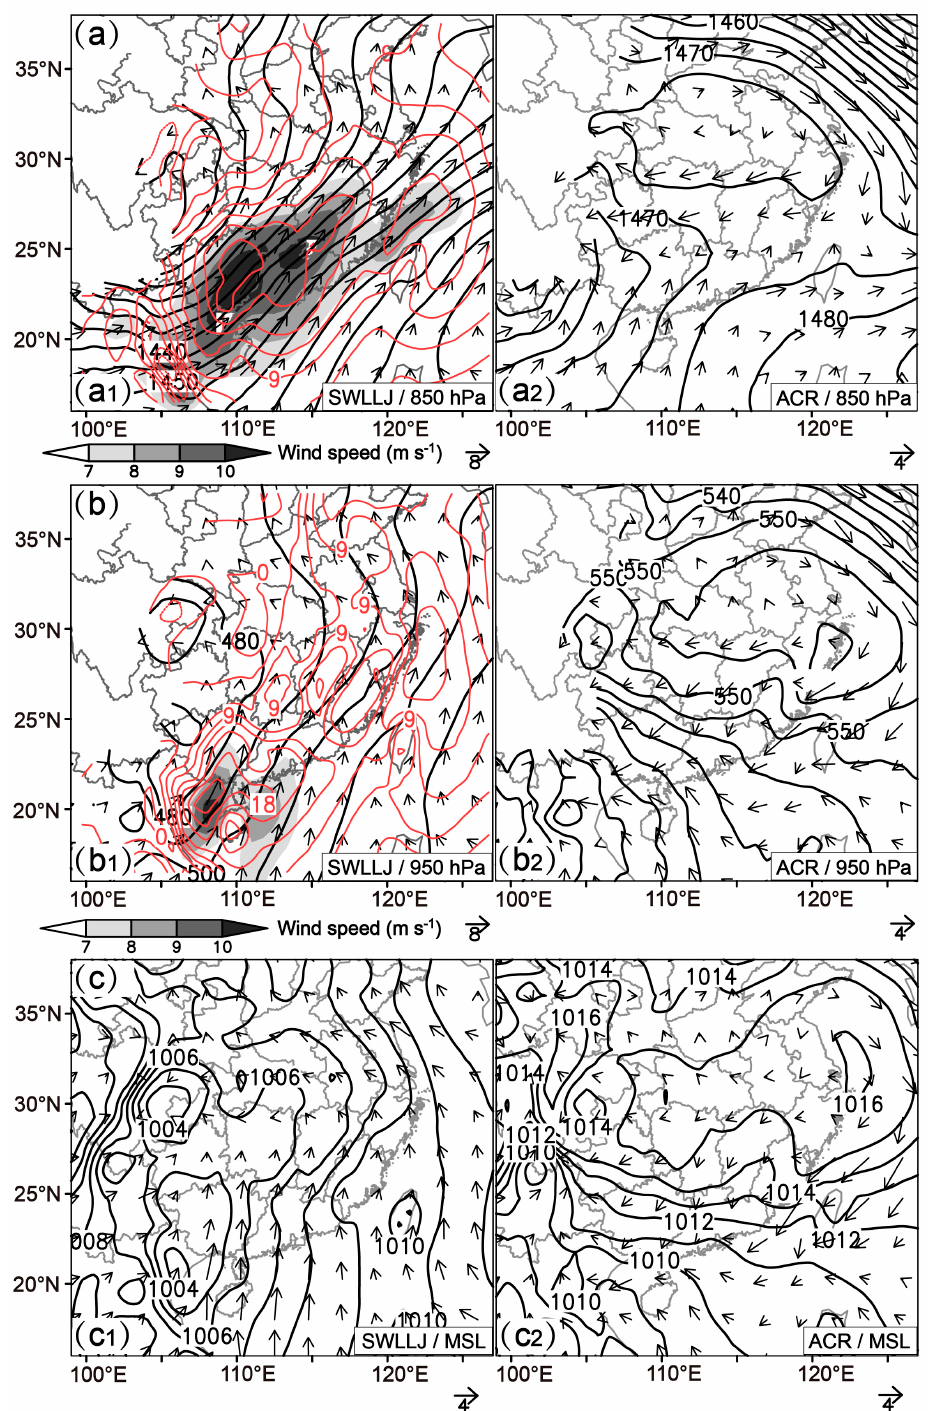
Figure 4. Two types ( a 1 , b 1 and c 1 representing synoptic situation SWLLJ; a 2 , b 2 and c 2 representing synoptic situation ACR) of composite ( a , a 1 and a 2 ) 850-hPa, ( b , b 1 and b 2 ) 950-hPa, and ( c , c 1 and c 2 ) mean-sea-level (MSL) circulations for the OWSRs over South China. SWLLJ and ACR represent 73 and 12 events, respectively. The black and red contours indicate geopotential heights ( a , a 1 and a 2 ; b , b 1 and b 2 ; units: gpm) or pressures ( c , c 1 and c 2 ; units: hPa) and temperature advection ( a 1 and b 1 ; positive and negative values indicate warm and cold advection, respectively; units: 10 − 5 K s − 1 ), respectively. The gray-shaded areas and vectors indicate wind speeds ( a 1 and b 1 ; units: m s − 1 ) and wind vectors (units: m s − 1 ),